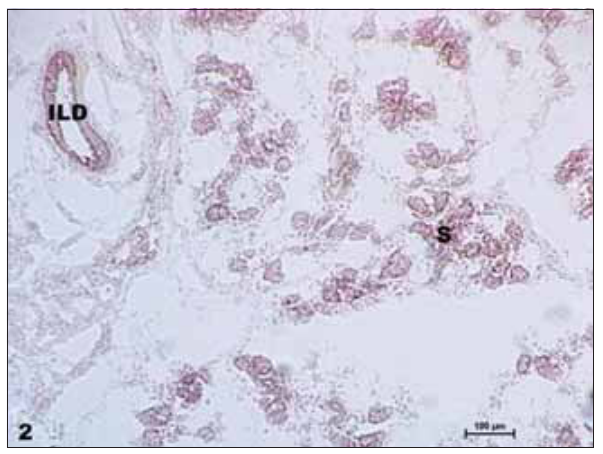
Figure-2: Photomicrograph at the age of 32 cm curved crown-rump length (145 days) showing moderate nicotinamide adenine dinucleotide phosphate diaphorase activity in serous acini (S) and interlobular duct of submandibular salivary gland of buffalo fetus (Nitro BT method × 100).